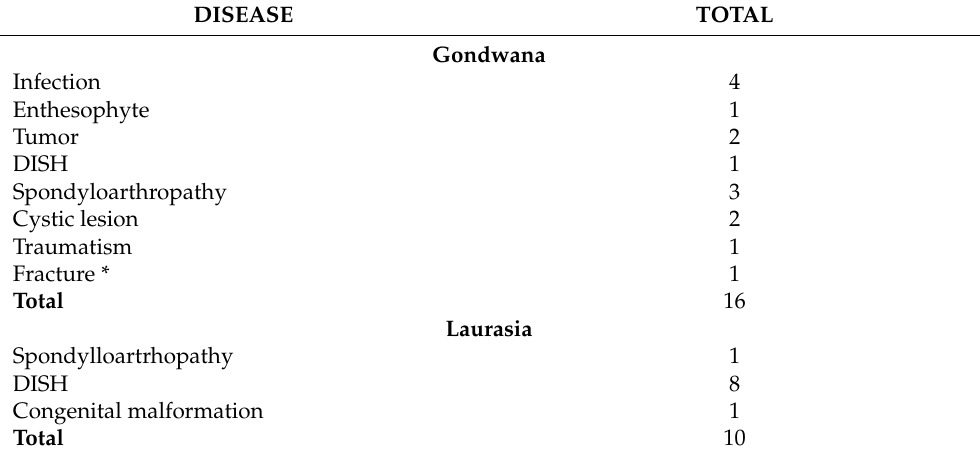
Table 1. Summary of the record of pathologies associated with the tails of sauropod dinosaurs distinguished by supercontinents (Laurasia and Gondwana) and by types of pathology. *, fracture associate to arch